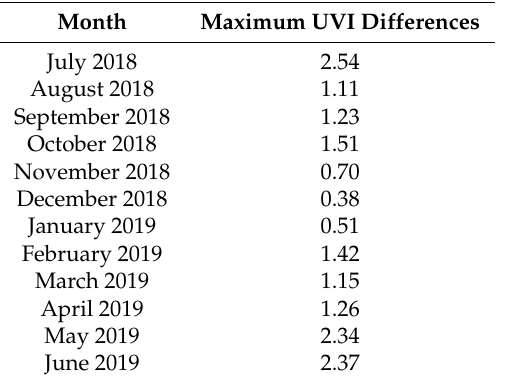
Table 3. Maximum monthly differences of UVI inside the greenhouse.